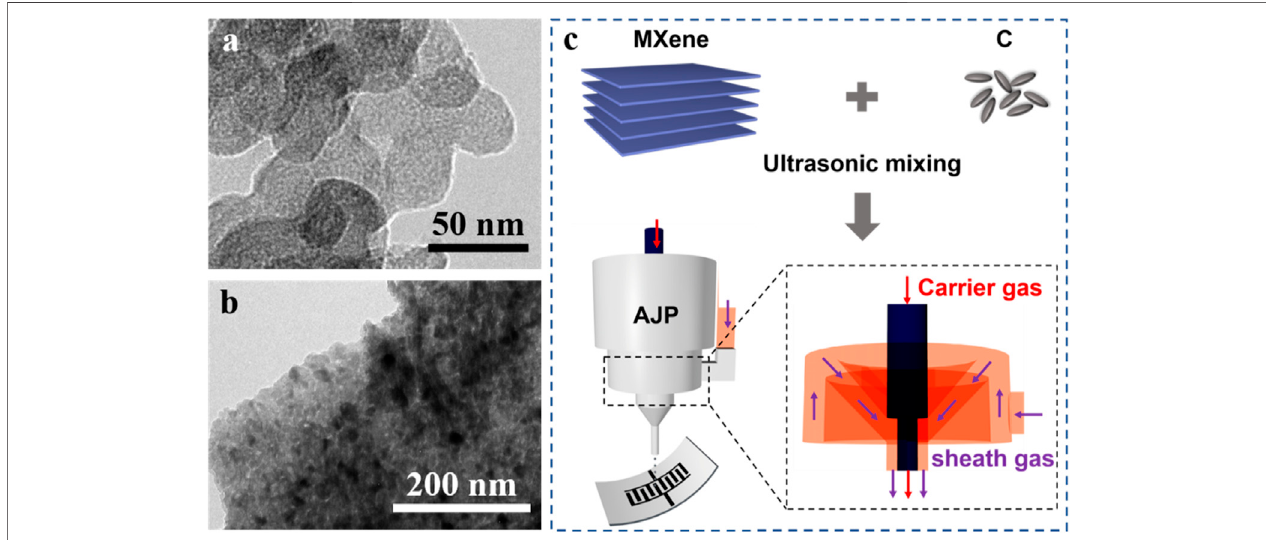
FIGURE 1 | (A , B) TEM images of the carbon nanoparticles and Ti 3 C 2 T x /C ink; (C) schematic illustration of the AJP process for fabrication of hybrid Ti 3 C 2 T x /C nanospheres.